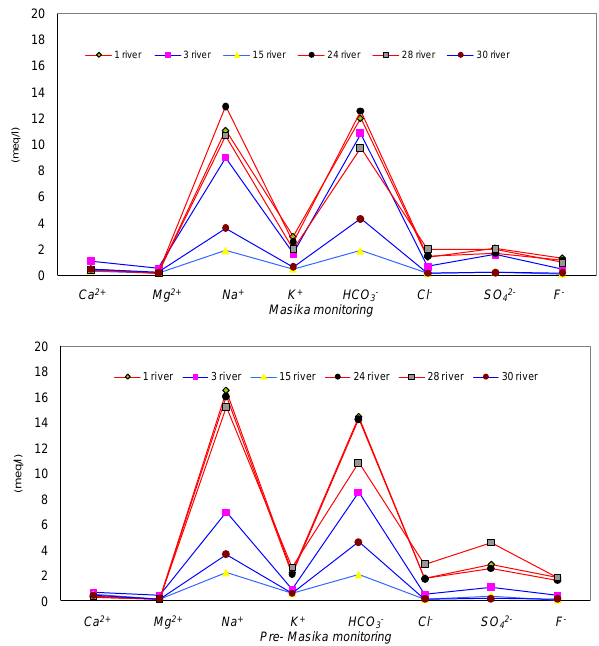
Fig. 6. Distribution of the major ions in river water